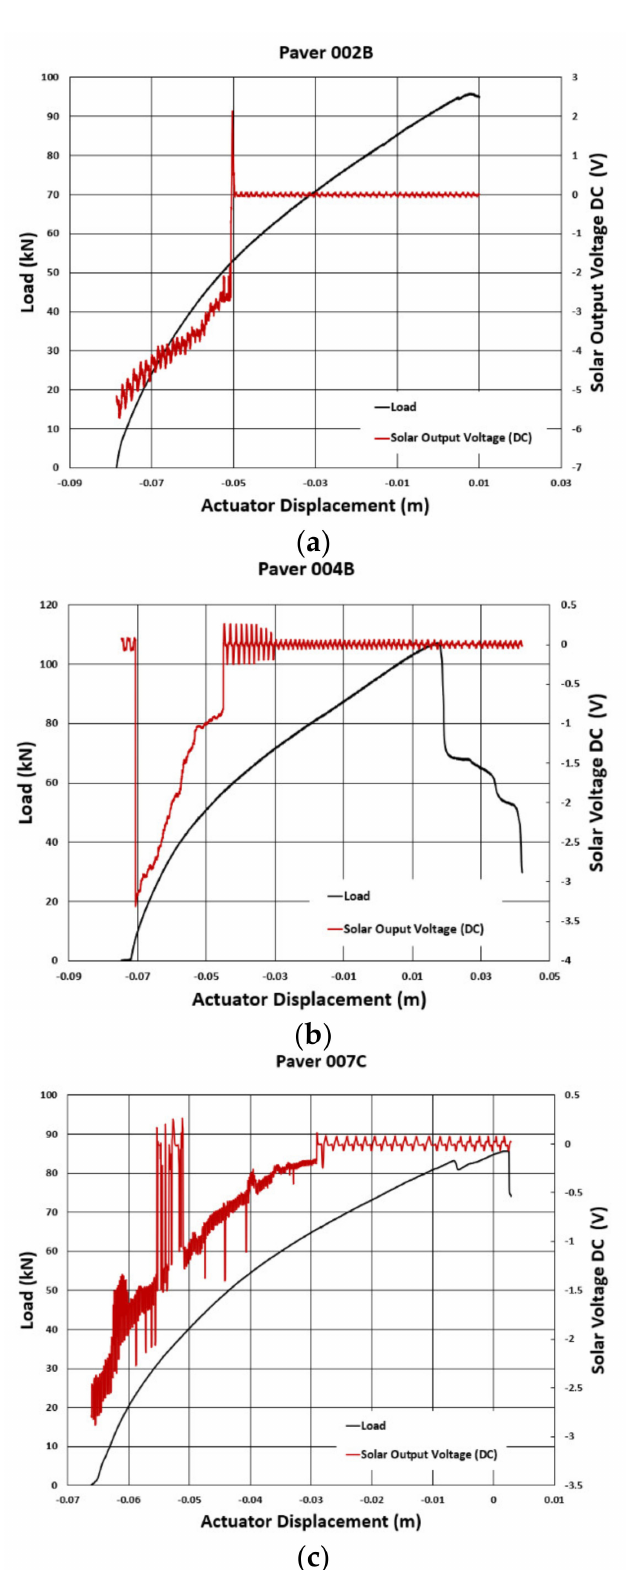
Figure 16. Load vs. actuator deflection with voltage output for ( a ) Paver 002B; ( b ) Paver 004B; and ( c ) Paver 007C (our material testing system (MTS) actuators are calibrated to within ± 1.0% over the full range of both load and